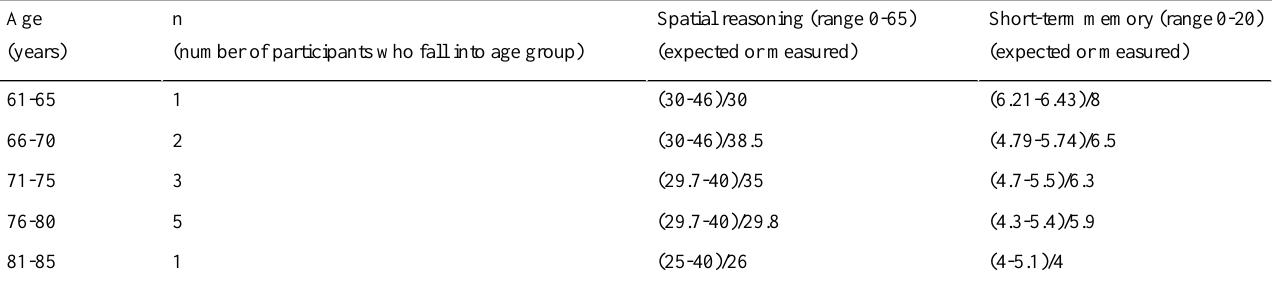
Table 4. Expected scores and mean measured scores for cognitive tests for all 12 participants. The average is compared with the expected score for that age group. Data presented in each